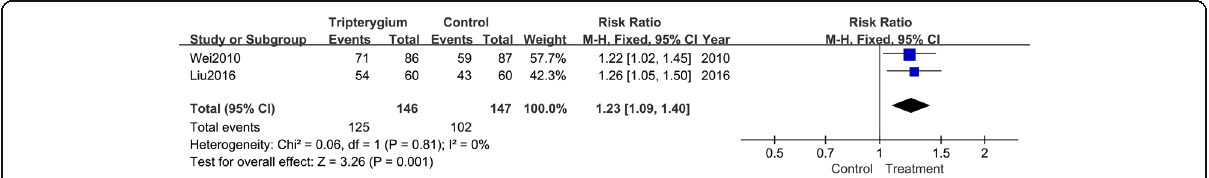
Fig. 7 Meta-analysis of Dermatology Life Quality Index. CI indicates confidence